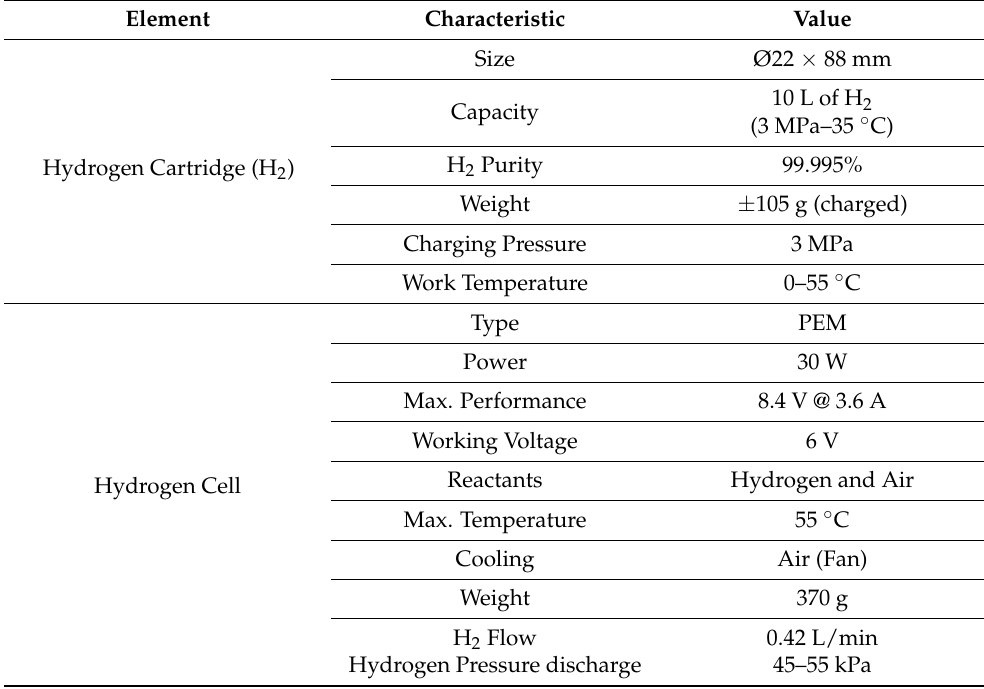
Table 1. Technical Characteristics of the Horizon Hydrogen Cell [24]. Element Characteristic Value